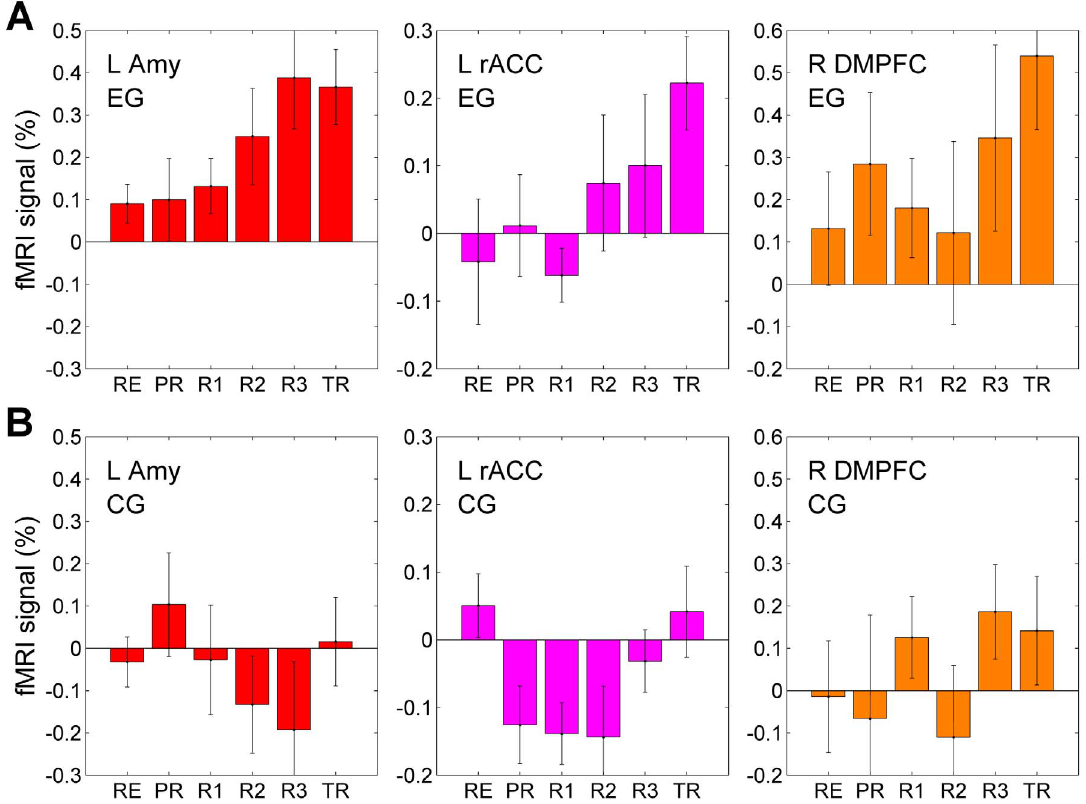
Figure 2 . Learned enhancement of control over BOLD activity and emotion induction. (A) Mean BOLD signal activity of the left amygdala during the rtfMRI neurofeedback (rtfMRI-nf) training for the experimental group (EG). The EG subjects received rtfMRI-nf based on the BOLD activity in the left amygdala ROI. Each bar represents a group average (mean 6 sem) of percent BOLD signal changes for the Happy Memories condition vs Rest condition for each of the six experimental runs: Rest (RE), Practice (PR), Run 1 (R1), Run 2 (R2), Run 3 (R3), and Transfer (TR). The enhancement in the left amygdala activity (red) was accompanied by increased activities of the left rACC (magenta), the right DMPFC (orange), as well as the other ROIs depicted in Fig. 1. (B) Lack of learned control over BOLD activity of the left amygdala and other regions for the control (sham) group (CG). The CG subjects received sham rtfMRI-nf based on BOLD activity in the left horizontal segment of the intraparietal sulcus (HIPS), presumably not involved in emotion regulation.